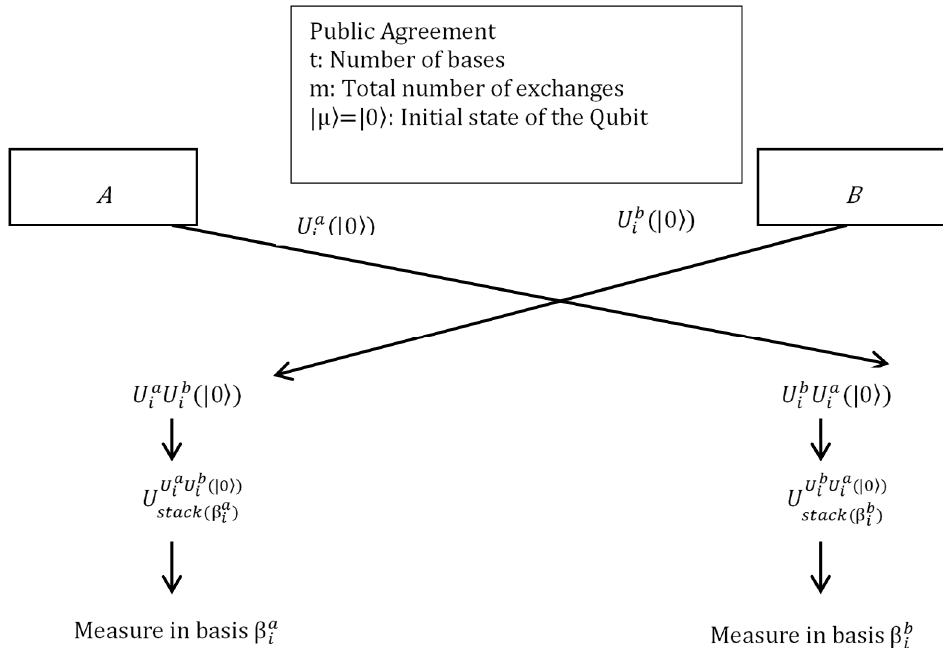
Figure 1. Outline of quantum two-party key-generation protocol.